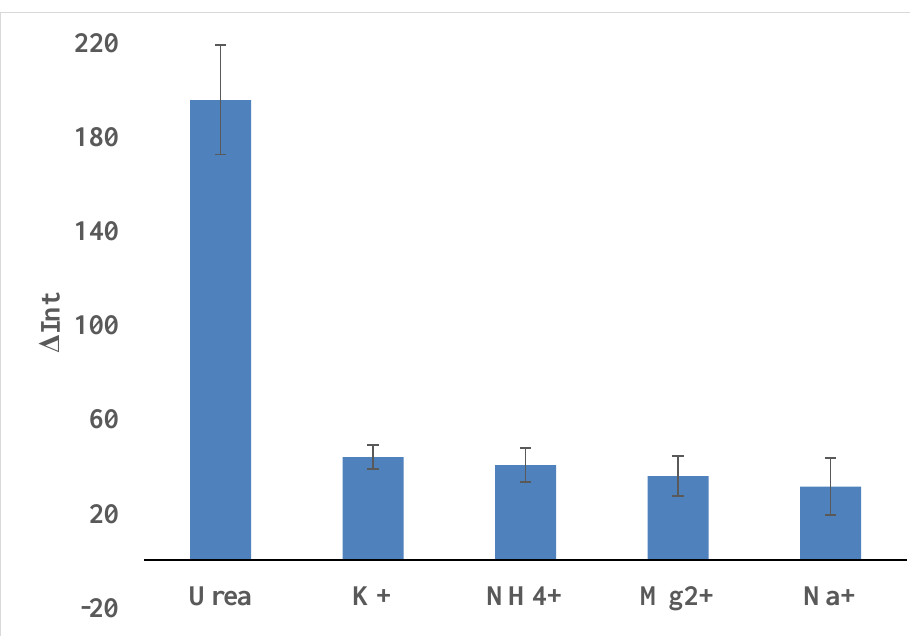
Figure 13. The maximum response changes of the biosensor towards various cations from 10 −5 to 10 −1 M and urea at the wavelength of 650 nm ( n = 3).